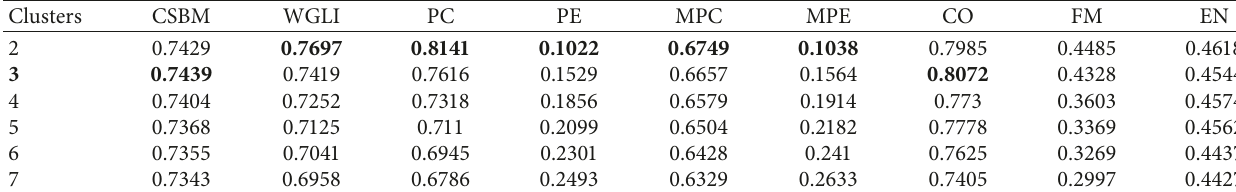
Table 6: Values of each index on the Hayesroth dataset.